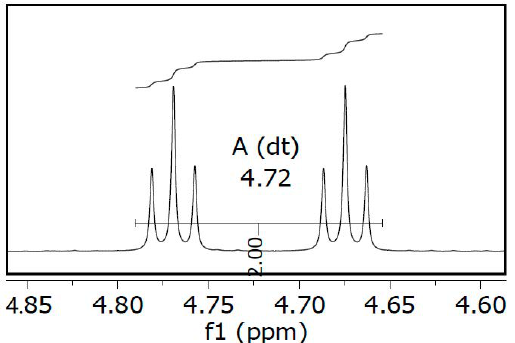
Figure 6. The partial 1 H-NMR spectrum of F- γ -T-3 reveals the distinctive coupling pattern of the fluoropropyloxy substituent at C6-O. These resonances are well separated from other aliphatic-H resonances and are therefore useful in distinguishing F- γ -T-3 from non-substituted T-3s.